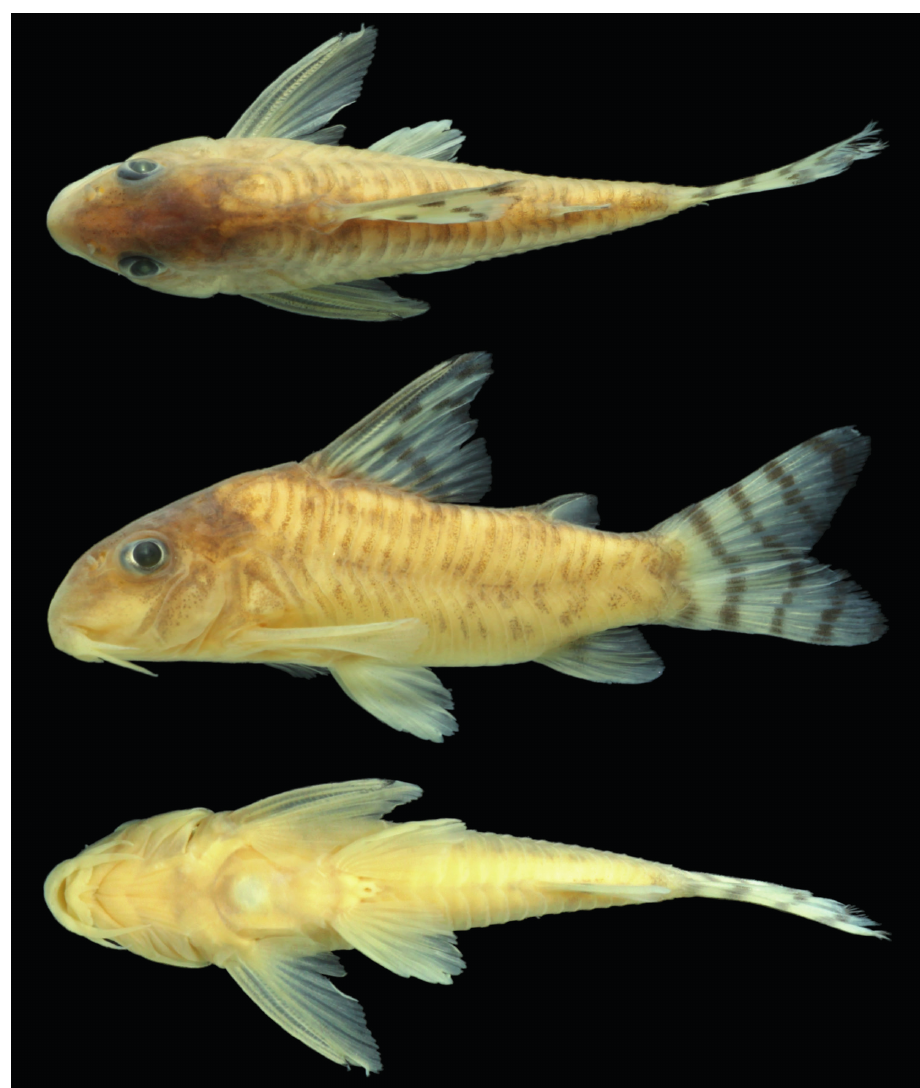
FIGURE 7 | Corydoras hypnos , holotype, MNRJ 53288, 31.7 mm SL, Brazil, Pará State, Novo Progresso Municipality, rio Jamanxim, a tributary to the rio Tapajós